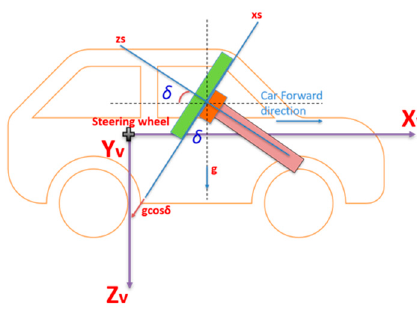
Figure 6. Steering angle estimation using CPD accelerometers.